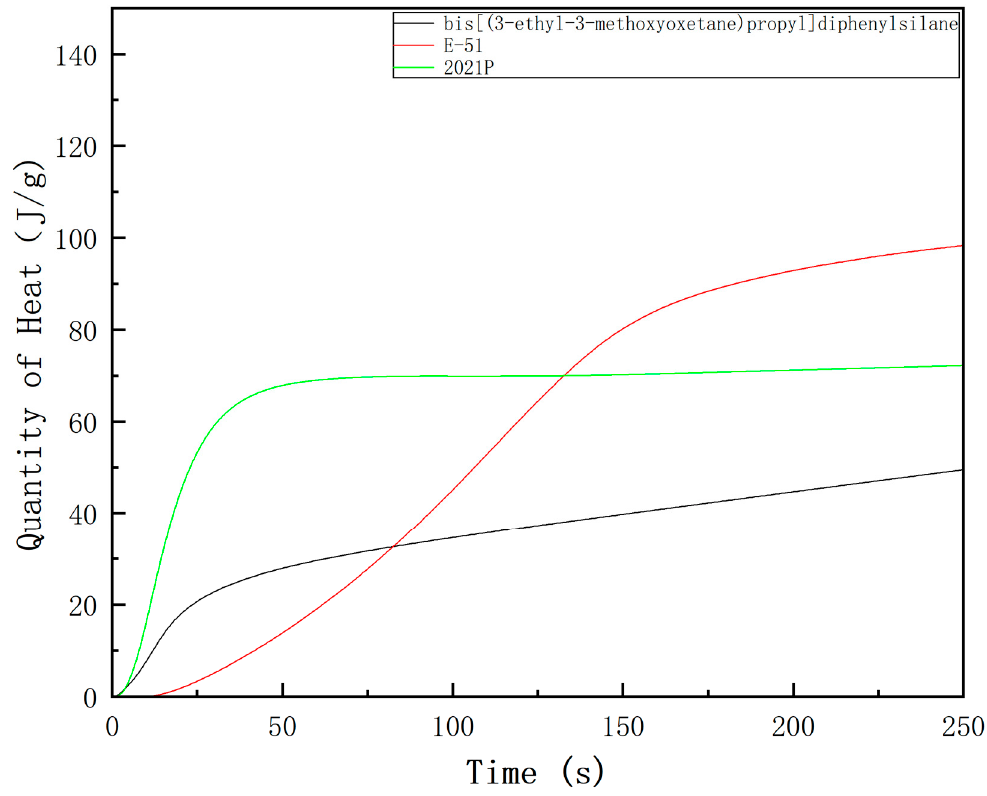
Figure 9. Heat quantity of bis[(3-ethyl-3-methoxyoxetane)propyl]diphenylsilane, E-51 and 2021 P. Table 4. Data of Photo-DSC.